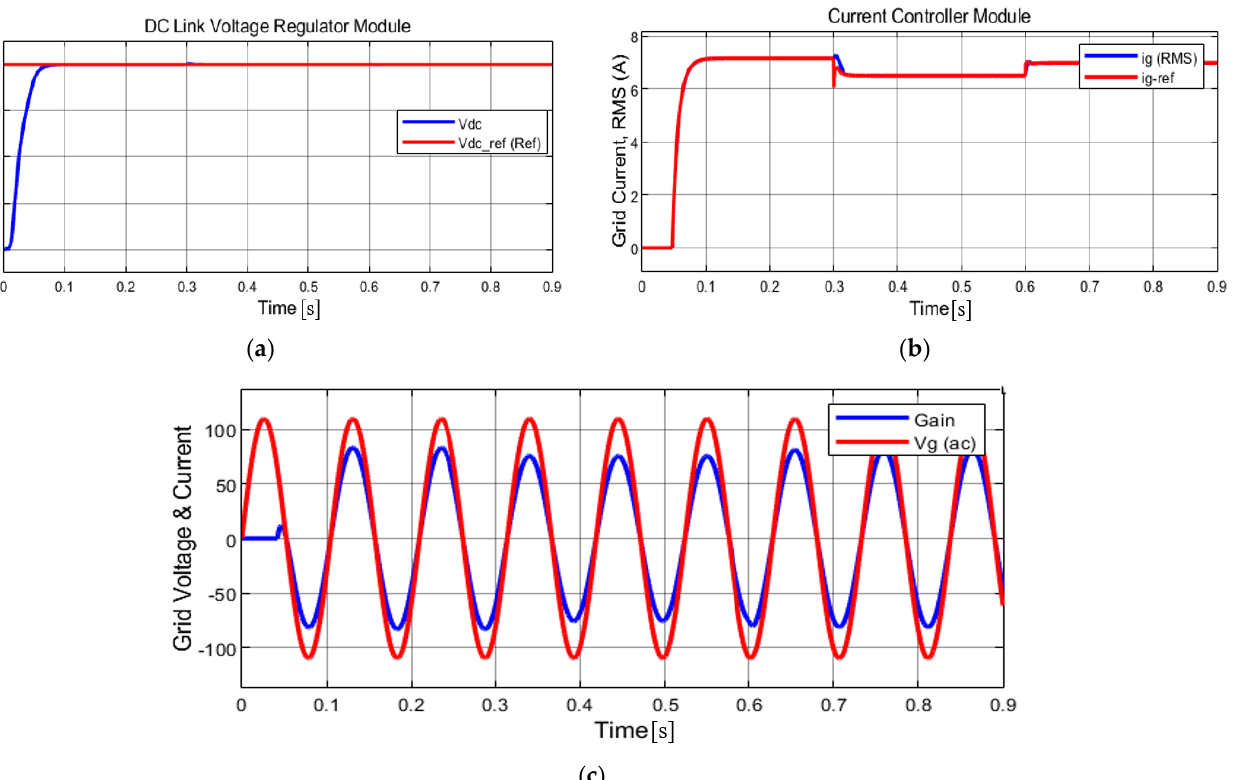
Figure 13. DC link voltage regulator module and current controller module performances with the LQR for constant solar irradiation case: ( a ) DC link voltage; ( b ) grid current magnitude; ( c ) grid voltage waveform V g (V) and current waveform where gain is 10 × Ig ( A )